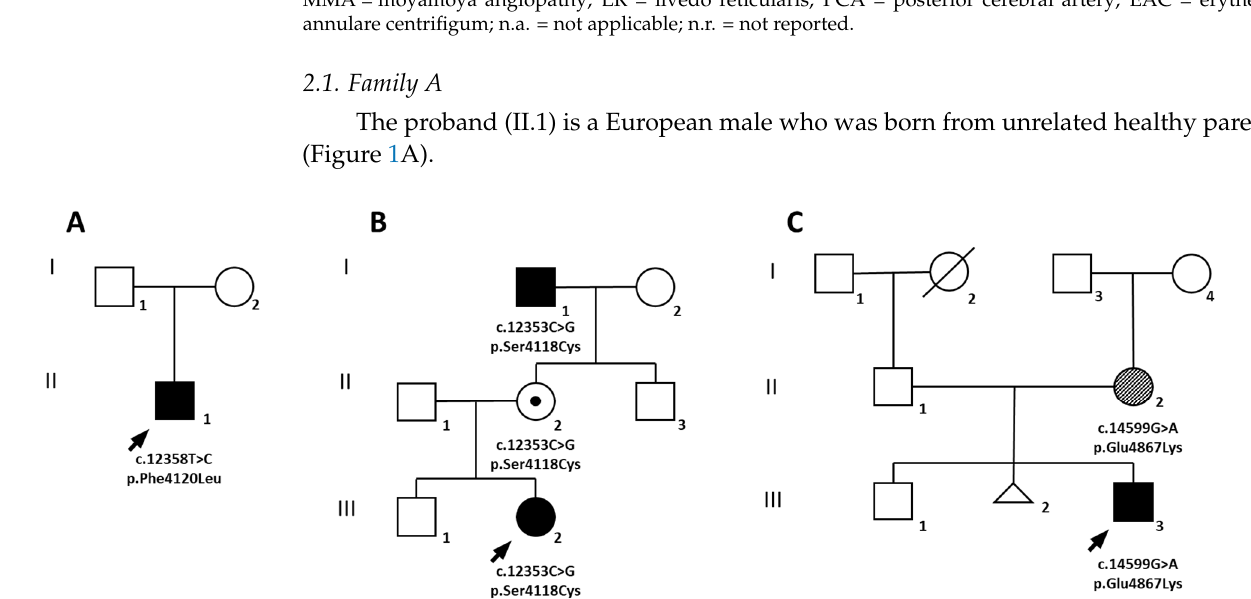
Figure 2. Imaging from probands of families A-C with bilateral moyamoya. Family A, patient II.1 ( A – E ): Magnetic resonance angiography (MRA) image showing severe bilateral narrowing of internal carotid arteries (ICAs; white arrows) and typical hypertrophic perforating collateral vessels (“puff